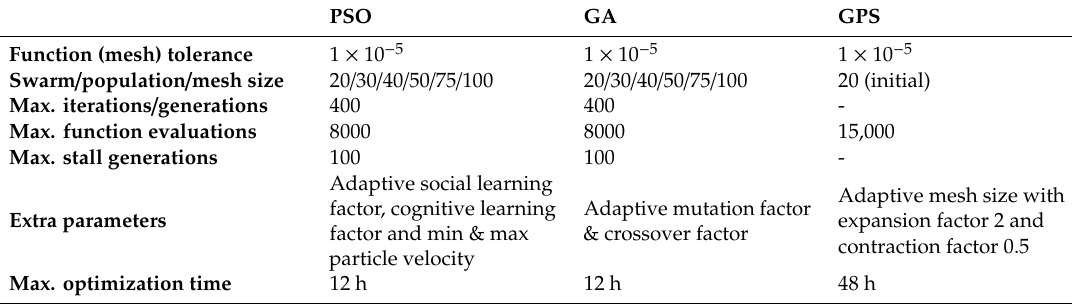
Table 3. Optimizer parameters of each algorithm for the simulated MPC.